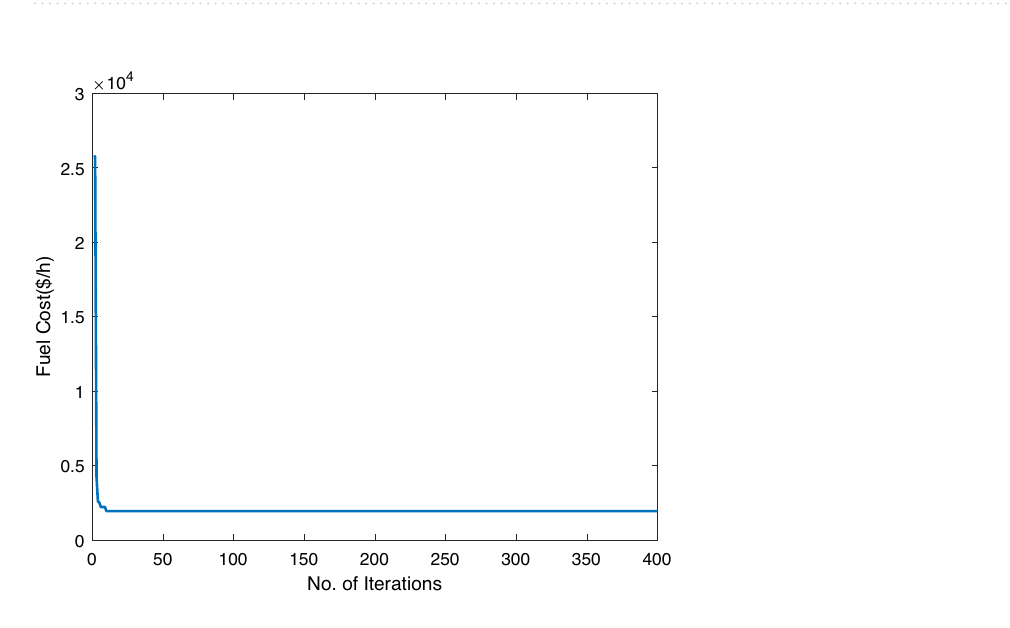
Figure 10. ABWO performance for case